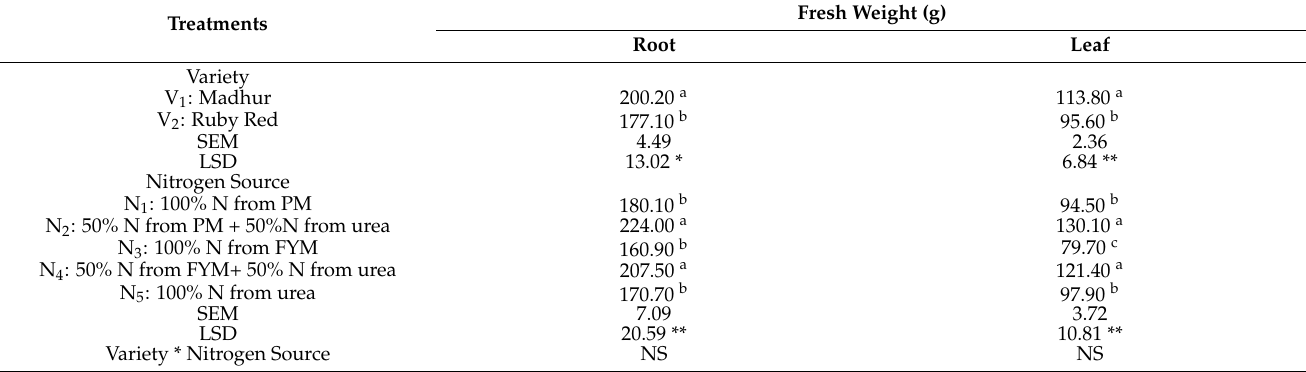
Table 7. Effect of variety and nitrogen source on root and leaf fresh weight of beetroot at AFU, Rampur, Chitwan in 2018/19.